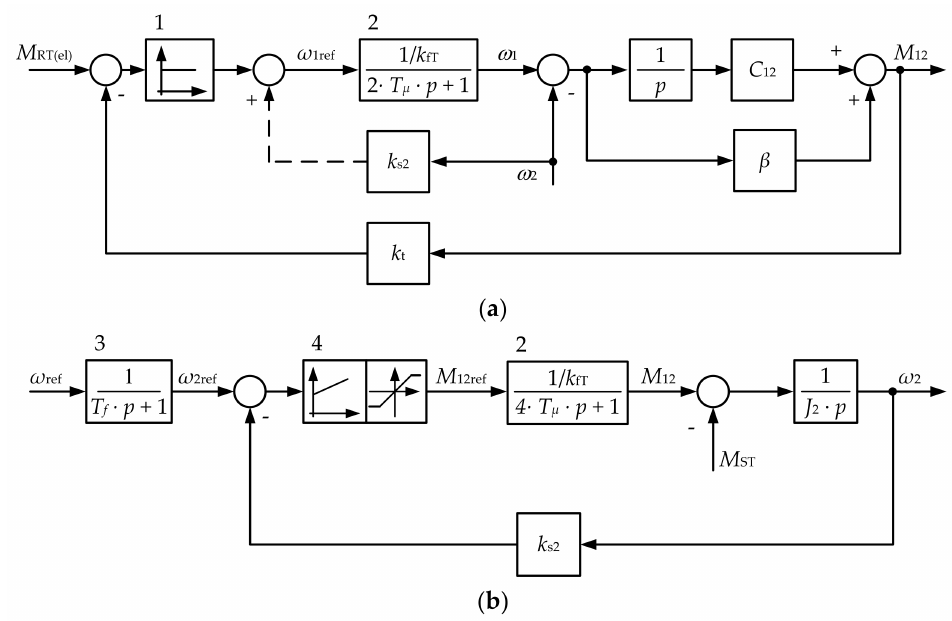
Figure 10. Block diagrams of closed-loop elastic torque control ( a ) for elastic torque and ( b ) for speed of the second mass: M RT (el) is the configured elastic torque; ω 1ref , ω 12ref are the configured speeds of the first mass and the second mass; 1 is the elastic torque controller; 2 is speed 1 closed loop; 3 is the filter; 4 is the speed 2 controller; k s 2 is the second mass speed feedback gain; k t is elastic torque feedback